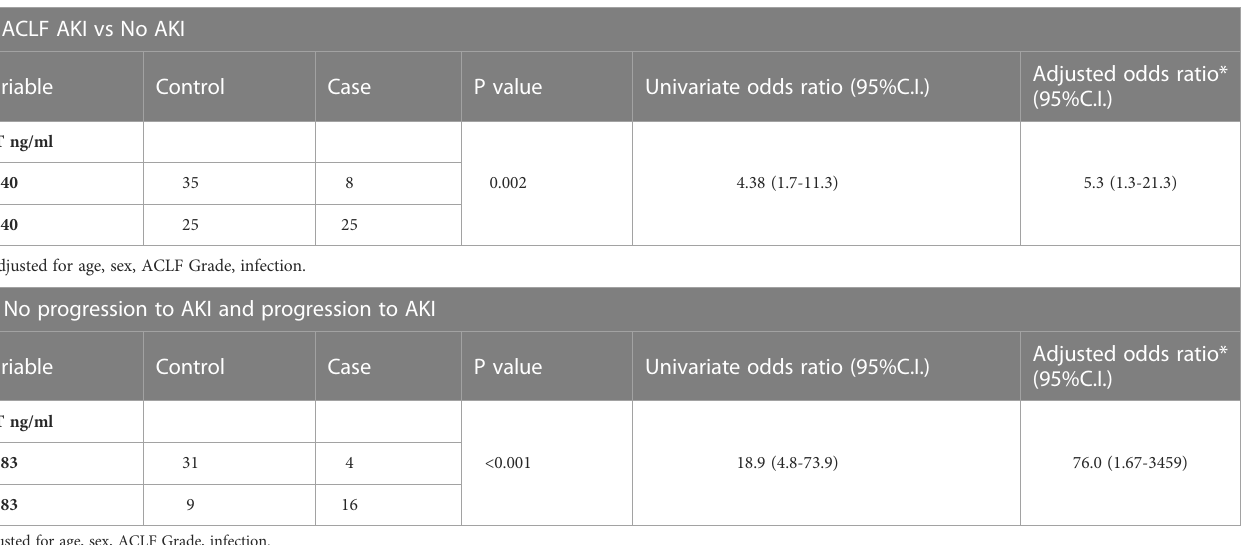
TABLE 7 Multiple logistic regression analysis to discriminate between (a) AKI vs no AKI and (b) progression of AKI in ACLF patients without AKI, based MT levels (ng/ml) cut-off.